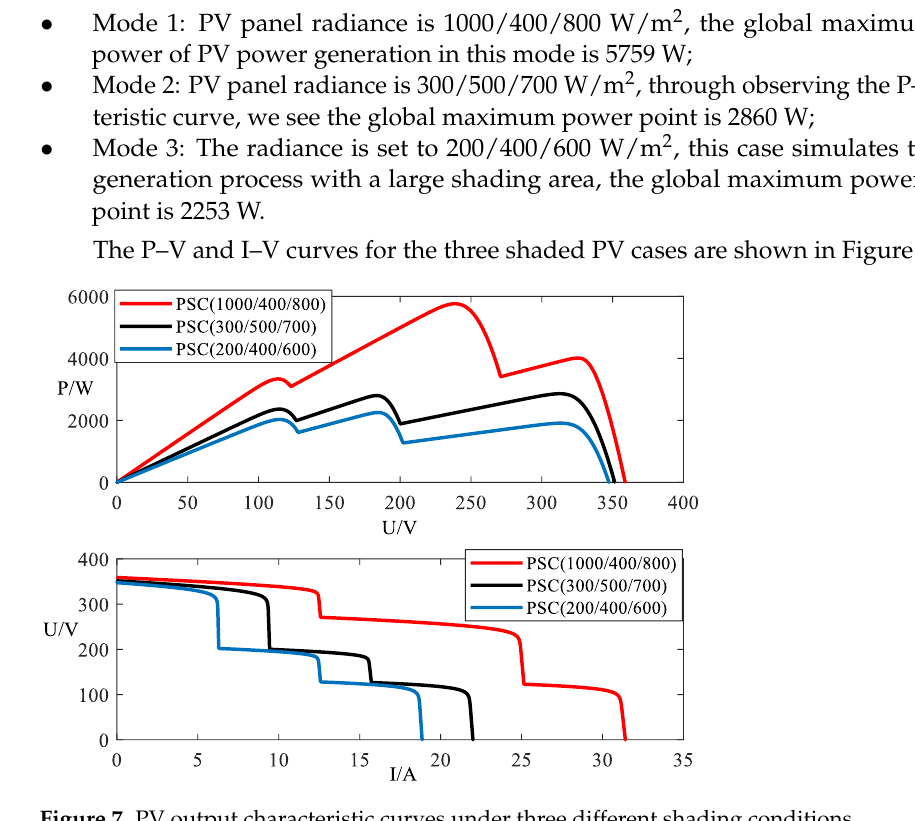
8 of 21 Table 2. Photovoltaic module related parameters. PV Module